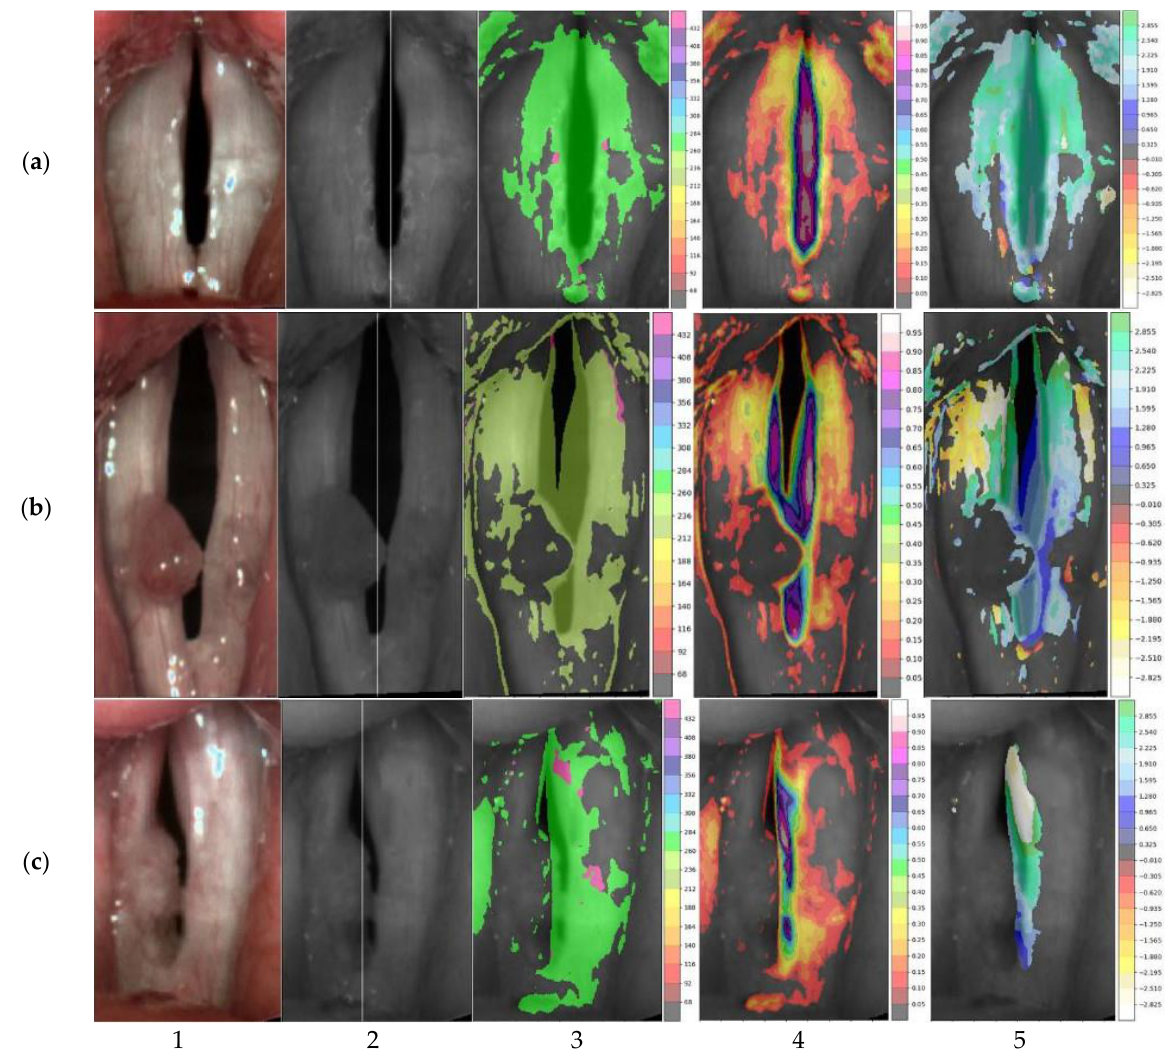
Figure 7. Representative HSV images recorded in normophonic subjects ( a ) and patients diagnosed with benign ( b ) and malignant glottal lesions ( c ). The first column shows the registered LHSV images, the second column shows their monochrome versions with the axis of symmetry drawn, the third column shows the amplitude maps of the fundamental frequency (with F0 values on colorbar), and the fourth and fifth columns show maps of the intensity (with its value on colorbar) of these harmonic vibrations and their phases correspondingly (with angle value in radians on colorbar). ( a ) SAI = 0.03. ( b ) SAI = 0.21. ( c ) SAI = 0.84